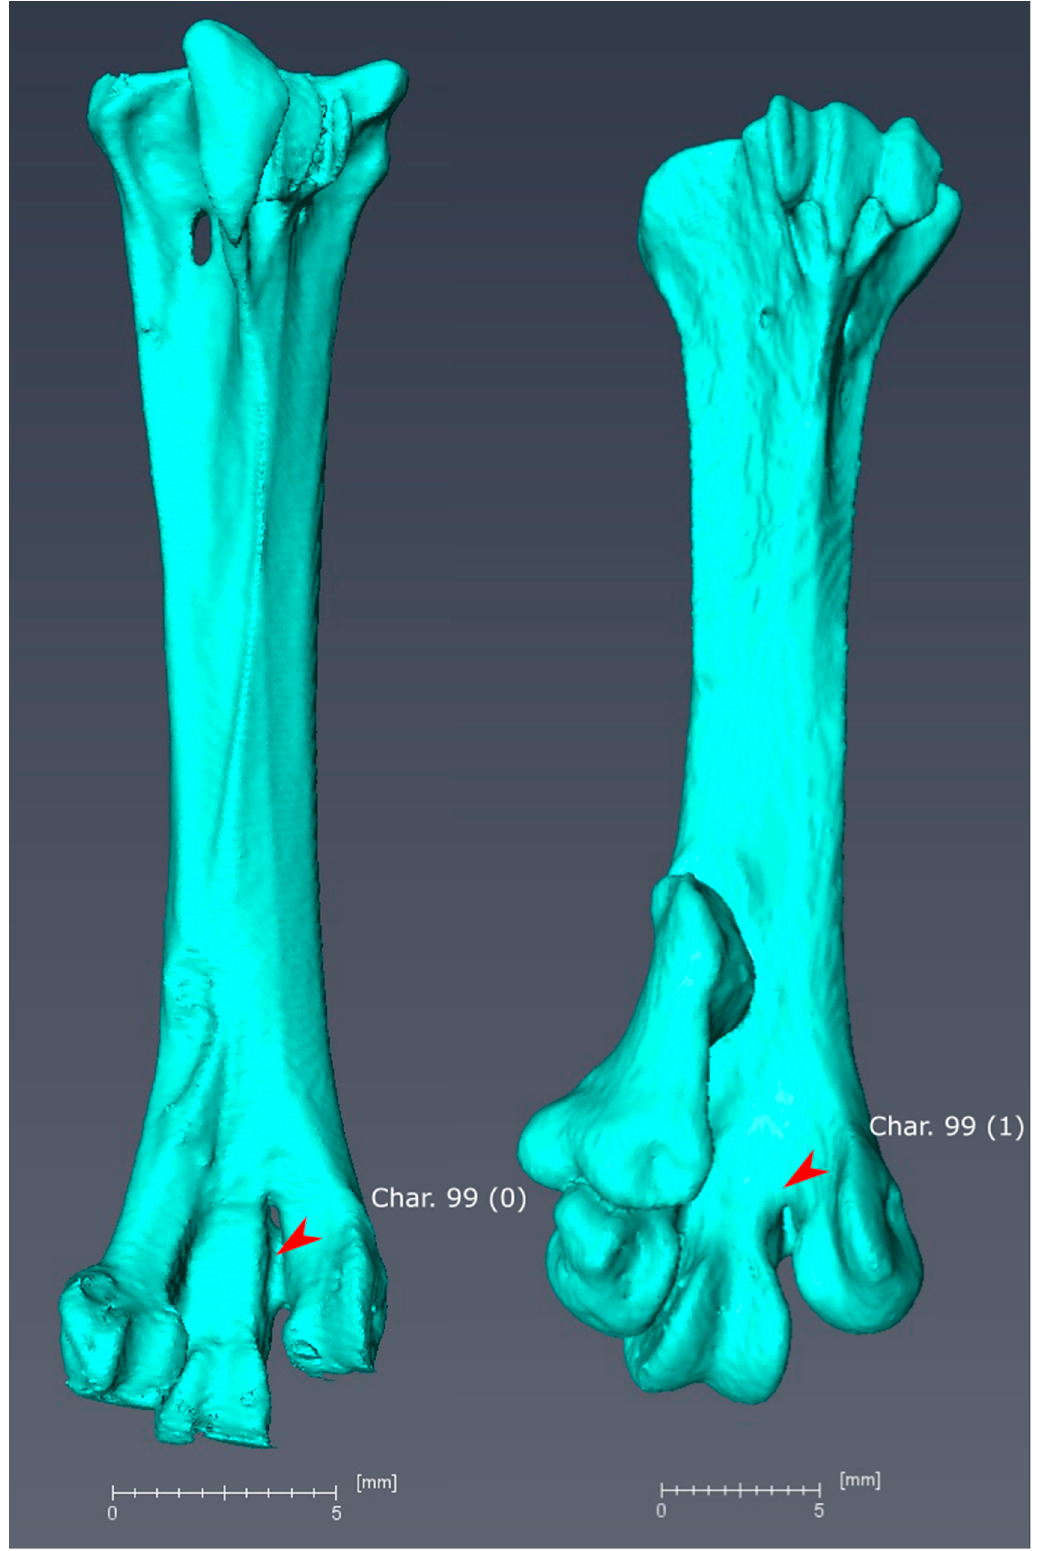
Figure A3. Tarsometatarsi of Columba livia (left) and Podargus strigoides (right) in plantar view. Columba exhibits state 0 for character 99 (distal interosseus canal of tarsometatarsus present), whereas Podargus exhibits state 1 (distal interosseus canal of tarsometatarsus absent, optimized as a synapomorphy of Podargidae + Daedaelornithes).